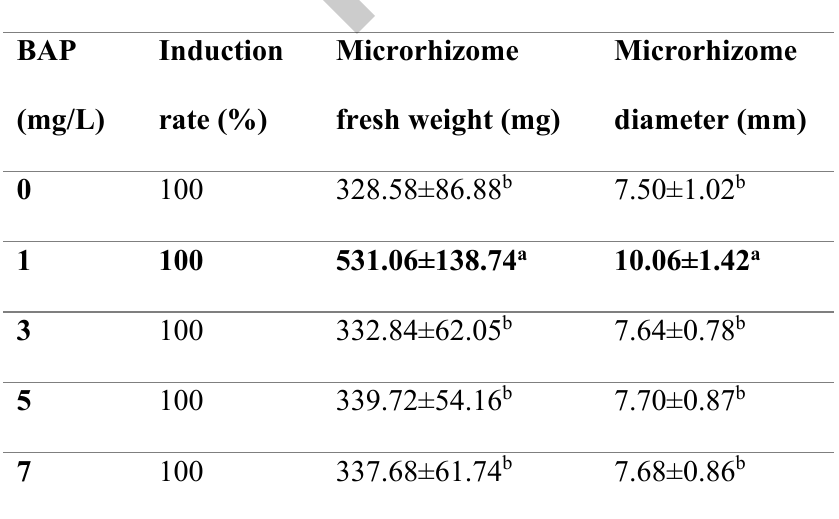
Table 2. Impact of different concentrations of 6-benzyl amino purine (BAP) on microrhizome induction and